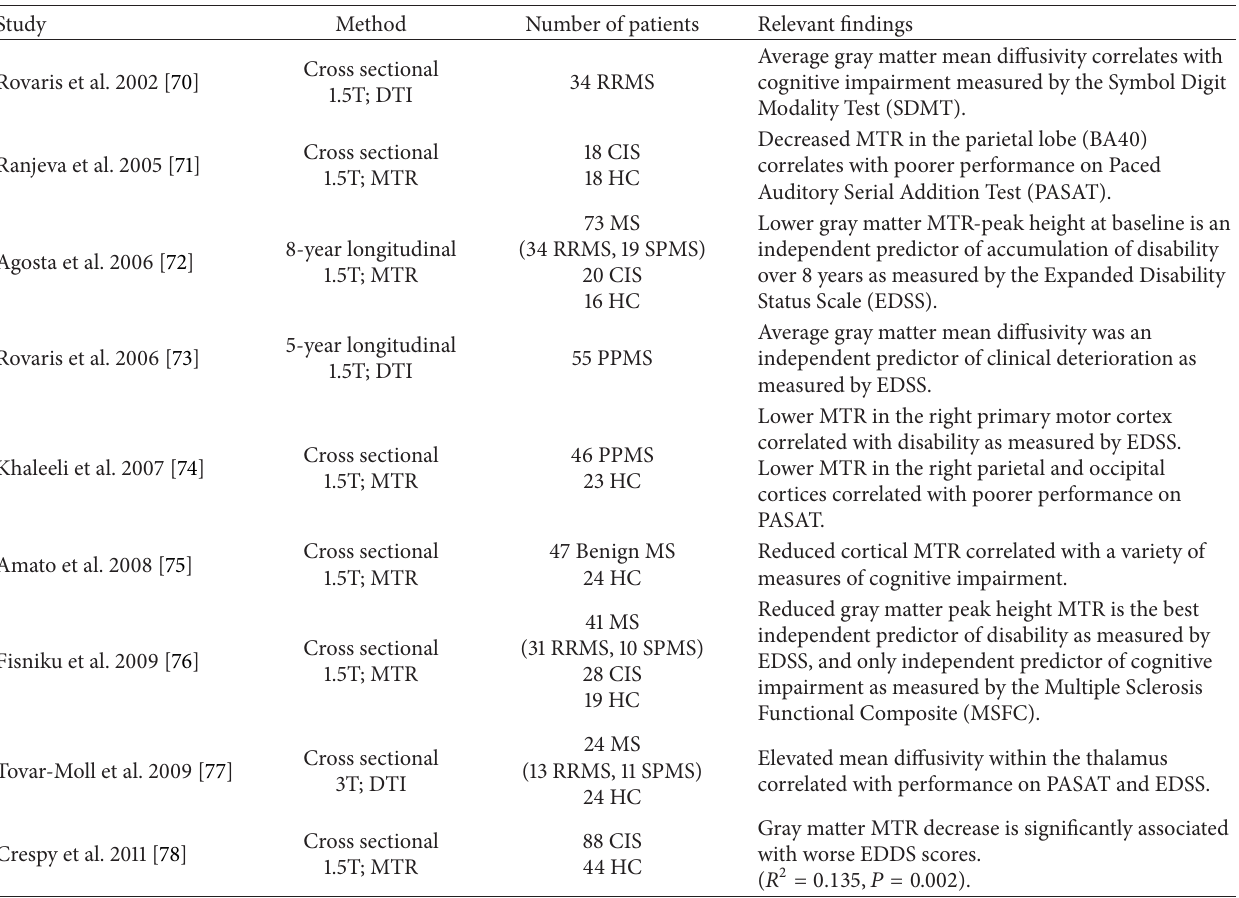
Table 2: Neuroimaging studies assessing the relationship between markers of diffuse damage in NAGM and clinical disability and cognitive